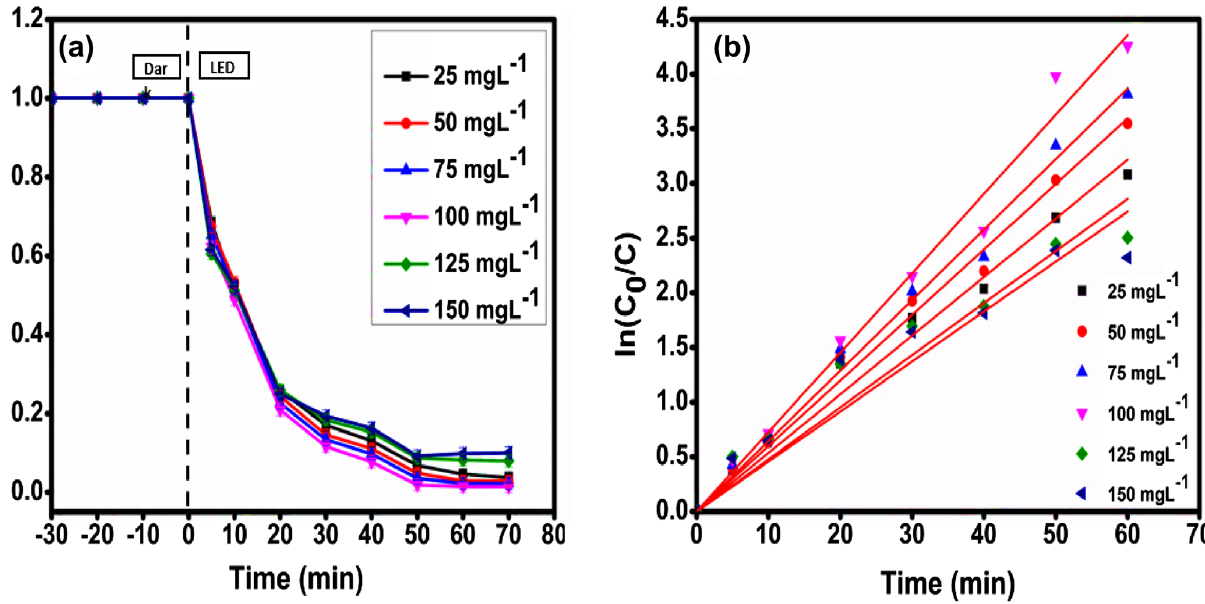
Figure 10. ( a ) Degradation profile and ( b ) kinetics plot for MG dye concentration optimization.